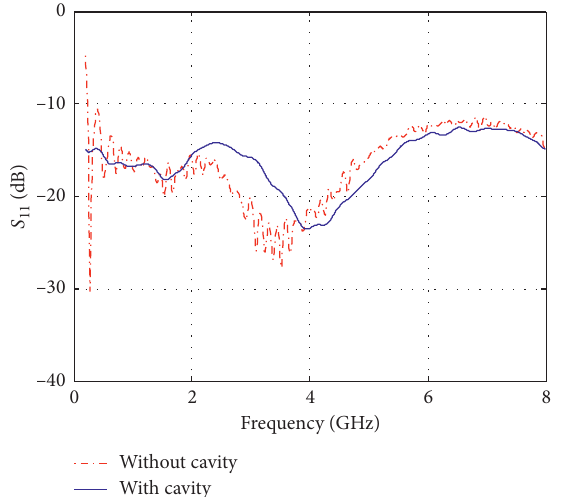
Figure 16: Simulated reflection coefficients of the SAAS antennas with and without a cavity.